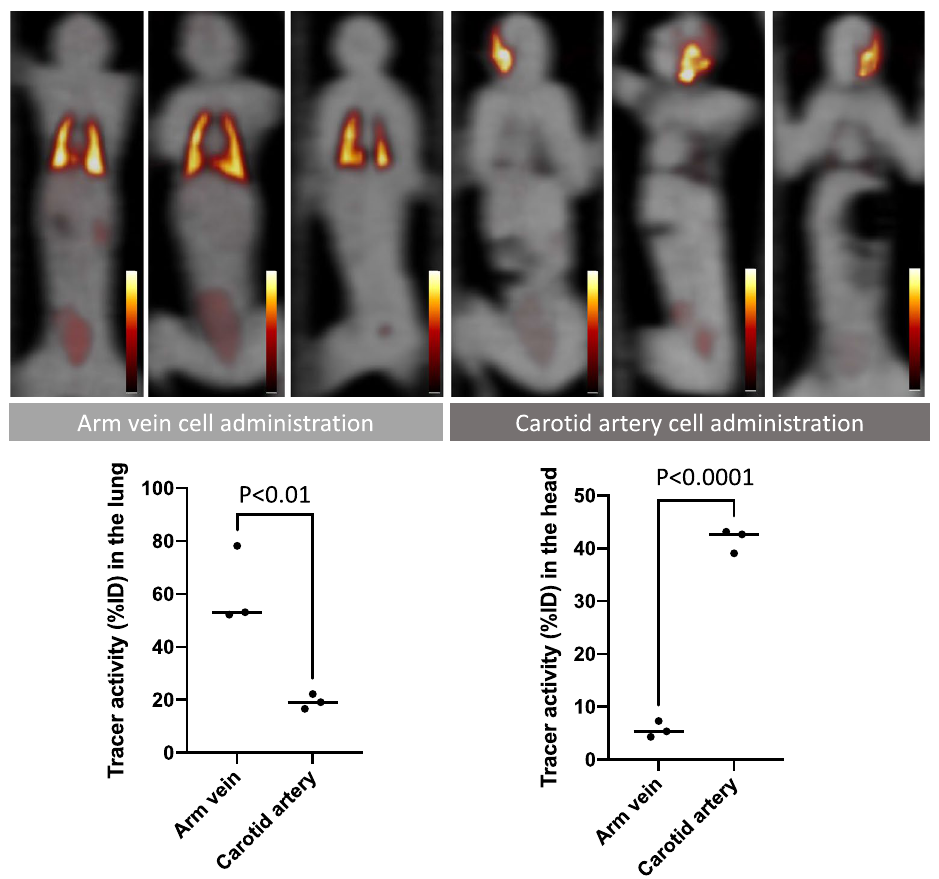
Figure 5. All whole-body PET coronal images of non-human primates (n = 6) after administration of [18F] FDG labeled MSCs via arm vein (n = 3, upper left) and common carotid artery (n = 3, upper right). PET images are fused with transmission scan images (gray scale). High activity in the bilateral lung is seen in the animals with cell injection via arm vein, while high activity in the head is seen in the animals injected via carotid artery. Quantitative PET signals in the lung (lower left) and the head area (lower right) with different cell administration routes are